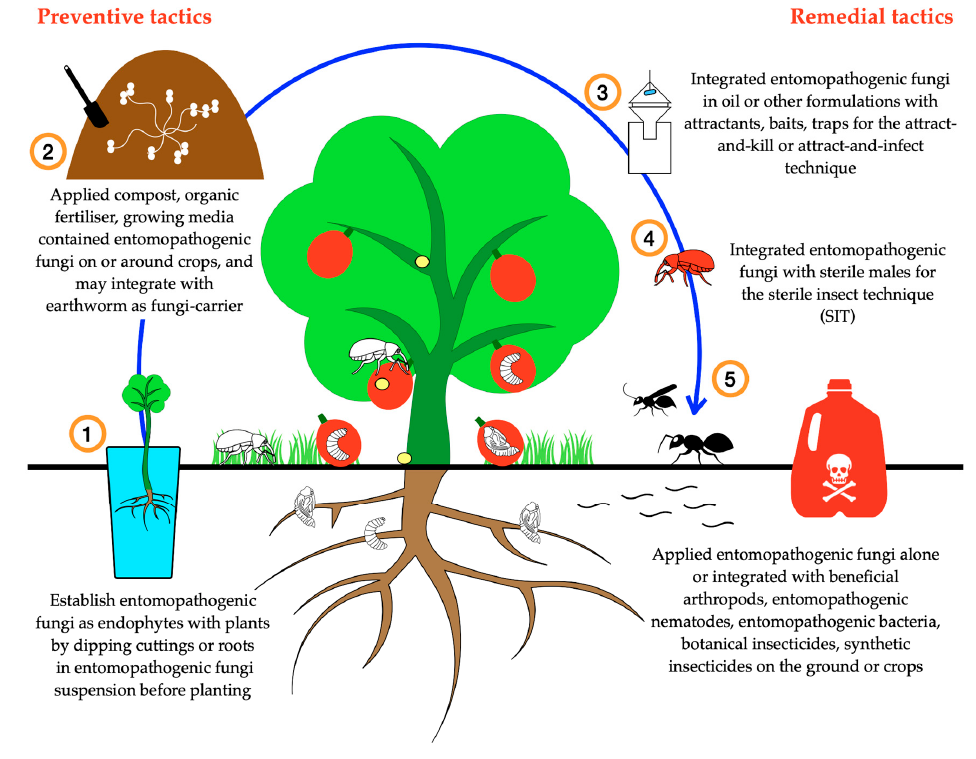
Figure 2. Conceptual illustration of potential uses of entomopathogenic fungi in IPM programs for managing weevils of horticultural crops. managing weevils of horticultural